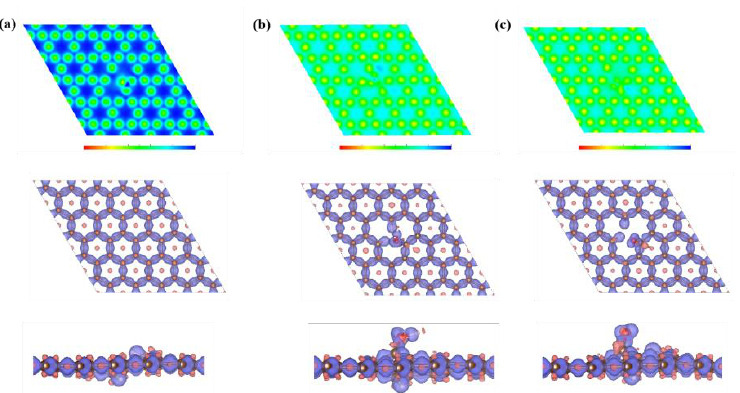
Figure 5. Deformation charge density maps of ( a ) pure carbon, ( b ) C-O, and ( c ) C=O and the corresponding side views.